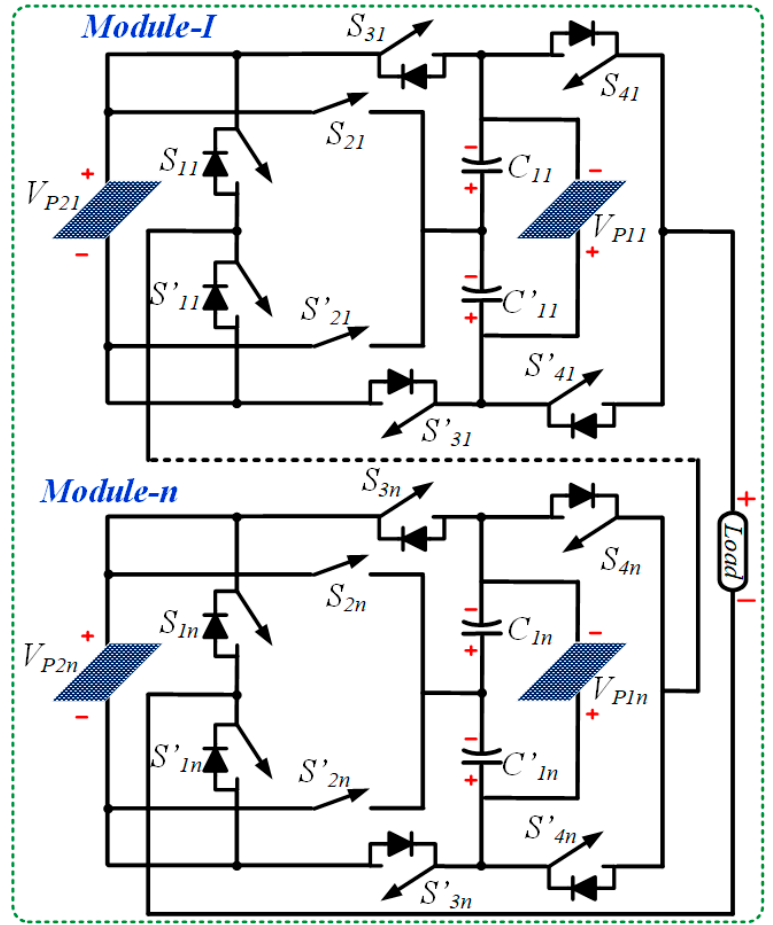
Figure 3. Cascaded structure of proposed topology with ‘ n ’ module.